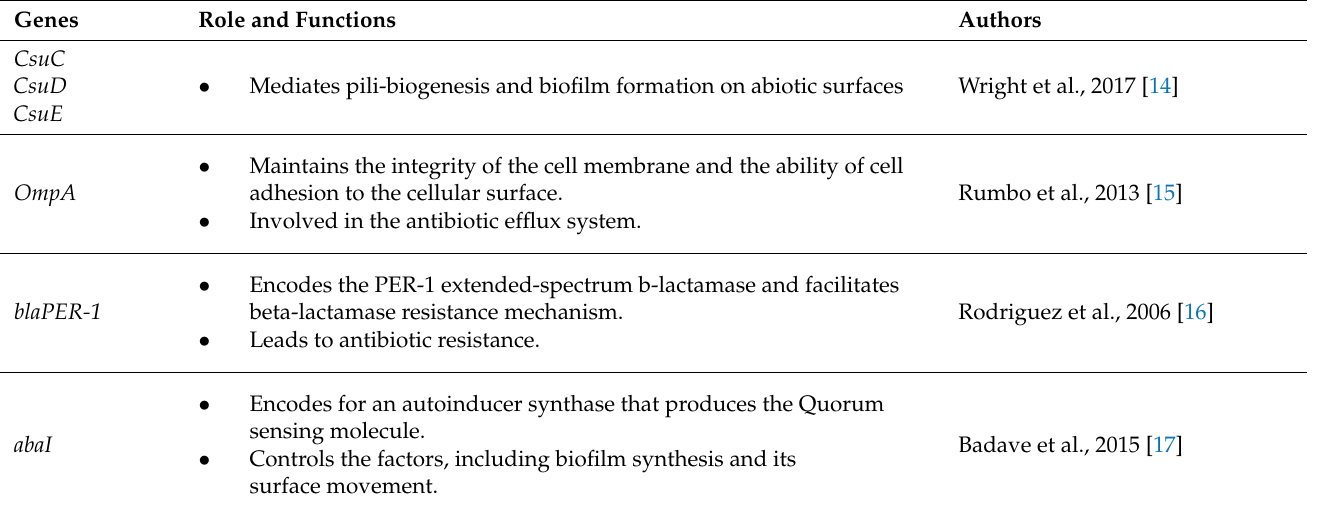
Table 1. Gene involvement in biofilm